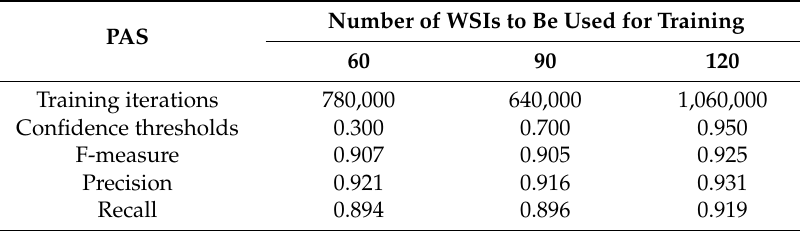
Table A1. Details of detection performance corresponding to the number of WSIs to be used for training the network (PAS).